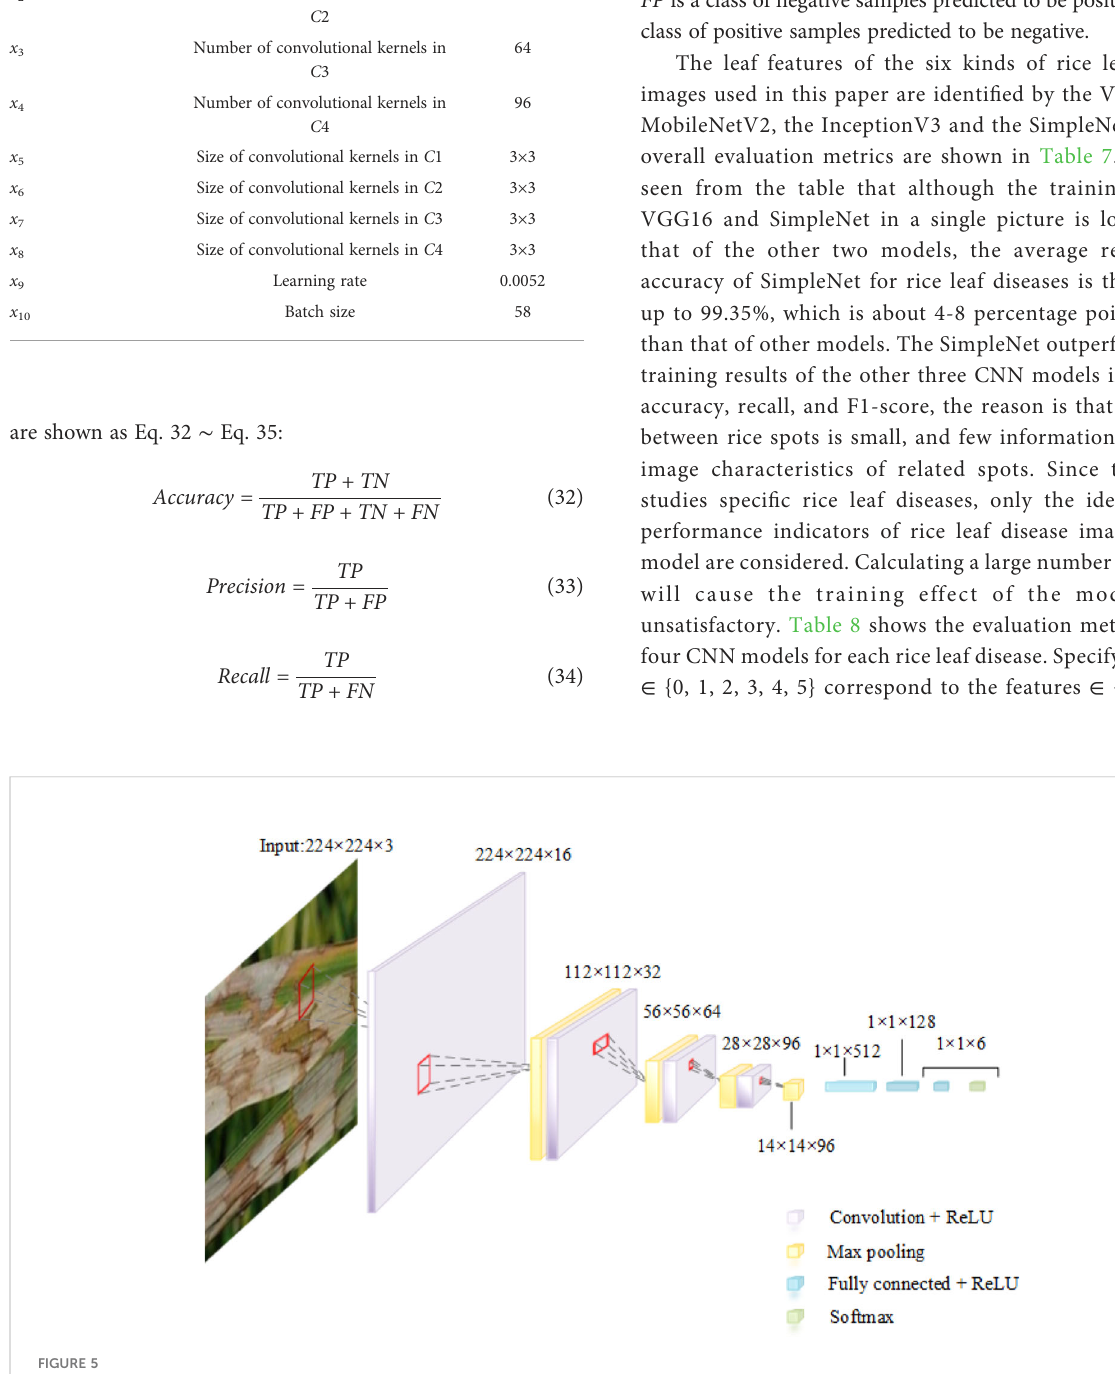
FIGURE 5 Schematic diagram of SimpleNet